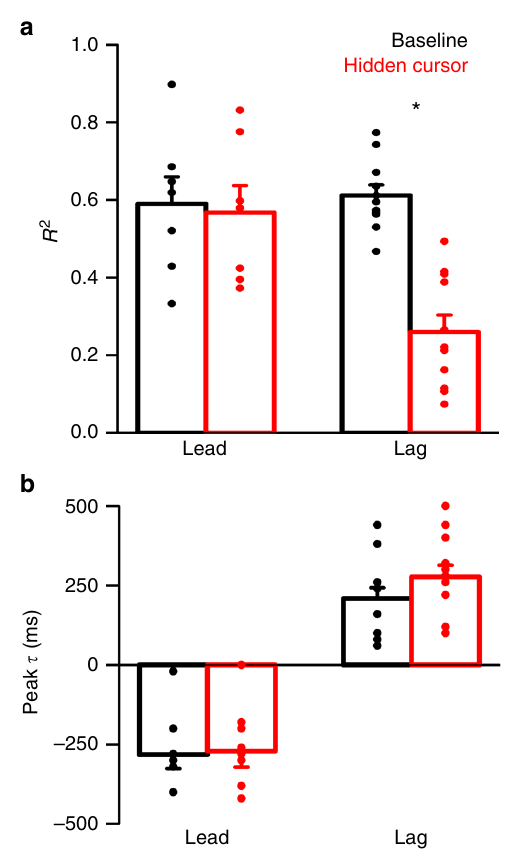
Fig. 7 Hidden cursor population results for position error encoding. a Average encoding strength ( R 2 ) of both lead and lag encoding for the 11 Purkinje cells with signi fi cant decreases in SS encoding of position error in the hidden cursor condition. Analysis of variance yielded a signi fi cant interaction between the feedback condition and the timing of encoding ( F (1,35) = 10.65, p = 0.0026, ANOVA) with a signi fi cant decrease in the amplitude of the lagging but not the leading R 2 . b Average timing of lead and lag SS encoding of performance in baseline and hidden cursor conditions is not signi fi cantly different ( F (1,45) = 1.04, p = 0.31,